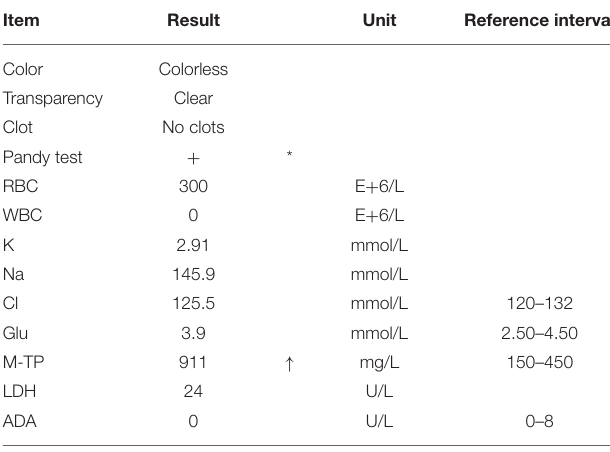
TABLE 1 | Analysis of cerebrospinal